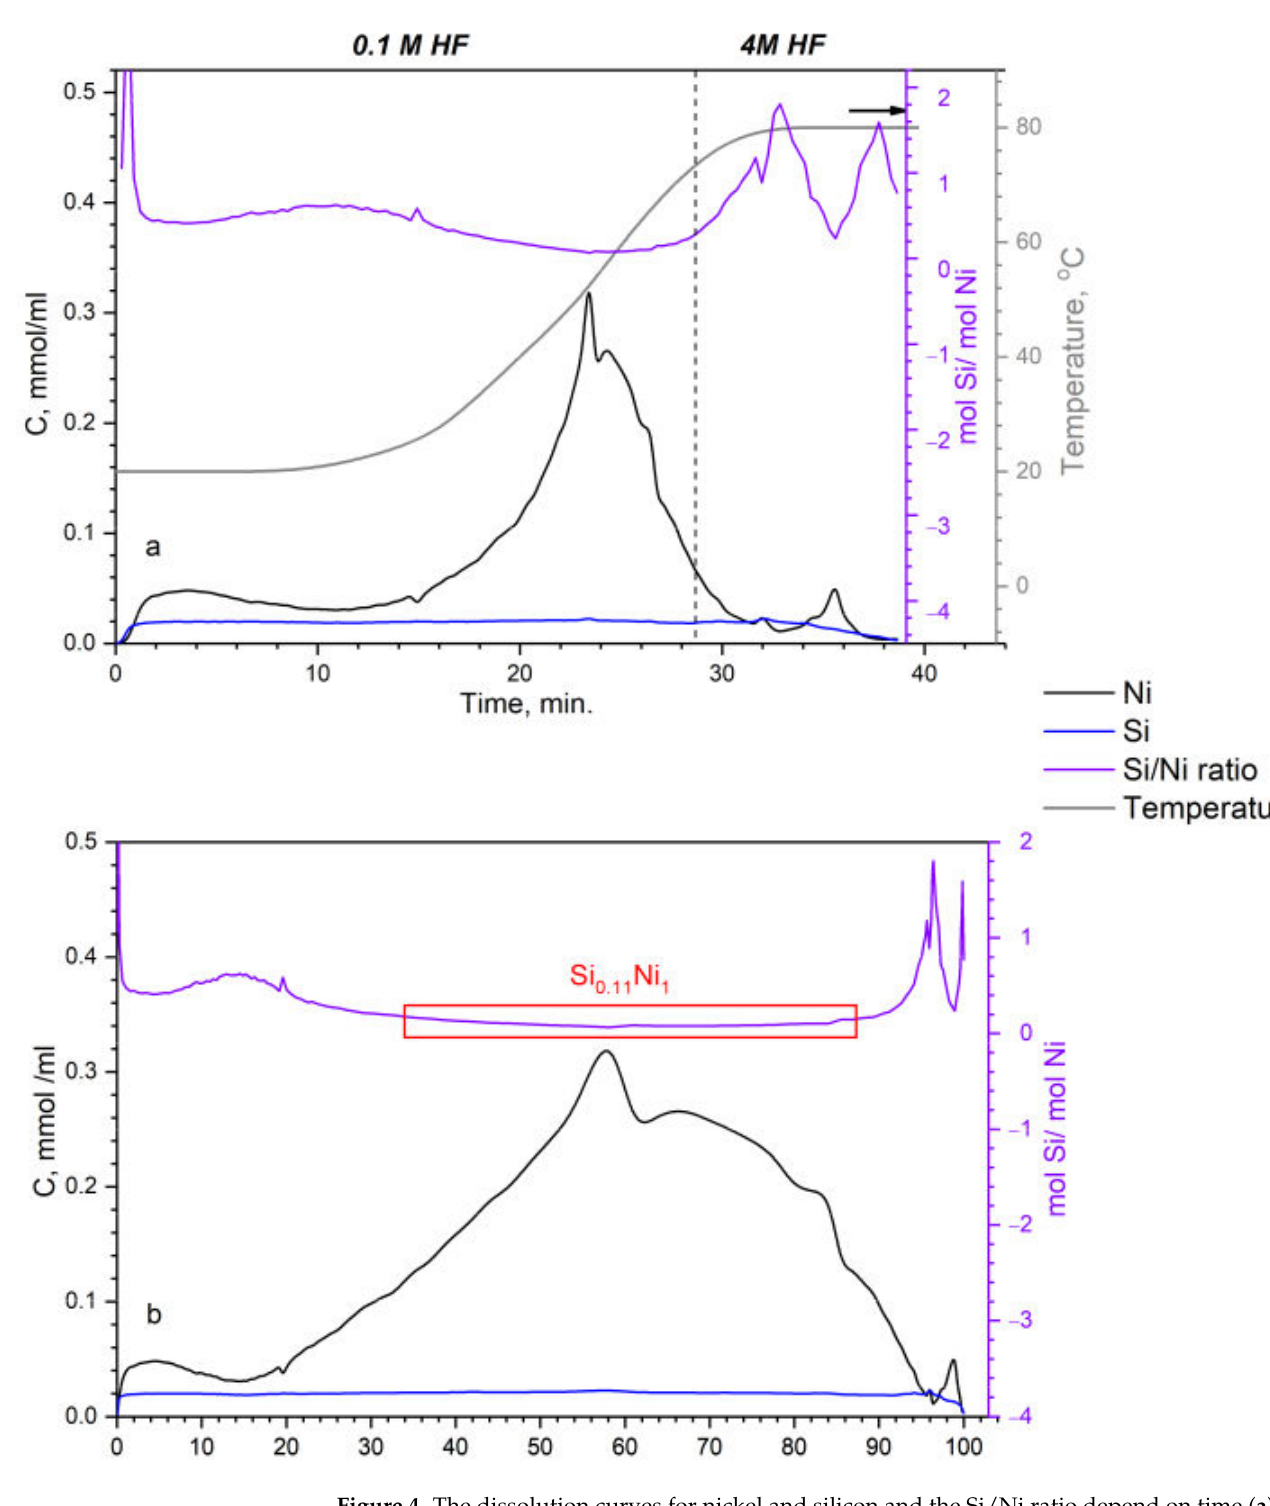
Figure 4. The dissolution curves for nickel and silicon and the Si/Ni ratio depend on time ( a ) and degree of Ni dissolution in at.% ( b ). The conditions of the dissolution depend on time ( a ). The red rectangle shows the area of constant Si:Ni ratio, equal to